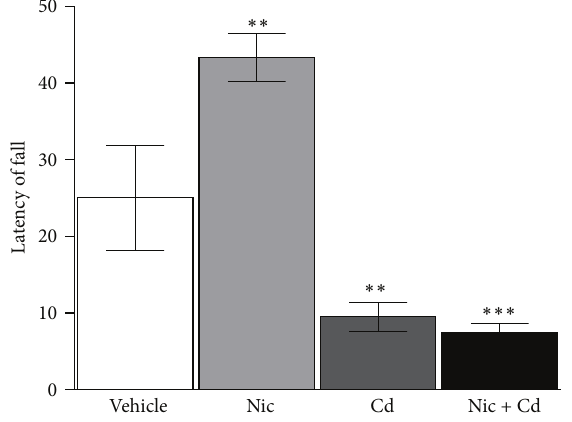
Figure 5: Latency of fall (LOF) in rotarod test for motor function. Treatment with nicotine increased the latency of fall significantly ( ↑ motor function) when compared with the control group ( 𝑃 < 0.05 ). This is attributed to the role of nicotine in stimulating cholinergic receptors at neuromuscular junctions and increasing epinephrine release. The cadmium ( 𝑃 < 0.01 ) and nicotine- cadmium ( 𝑃 < 0.001 ) treated groups showed a significant decrease in motor function ( ↓ LOF) when compared with the control and nicotine treated group ( 𝑃 < 0.001 ). Subsequent analysis shows that nicotine-cadmium treatment reduced motor function significantly when compared with nicotine ( 𝑃 < 0.001 ) and cadmium ( 𝑃 < 0.05 ) treatment groups, respectively ( statistical significance : ∗ 𝑃 < 0.05 , ∗∗ 𝑃 < 0.01 , and ∗∗∗ 𝑃 < 0.001